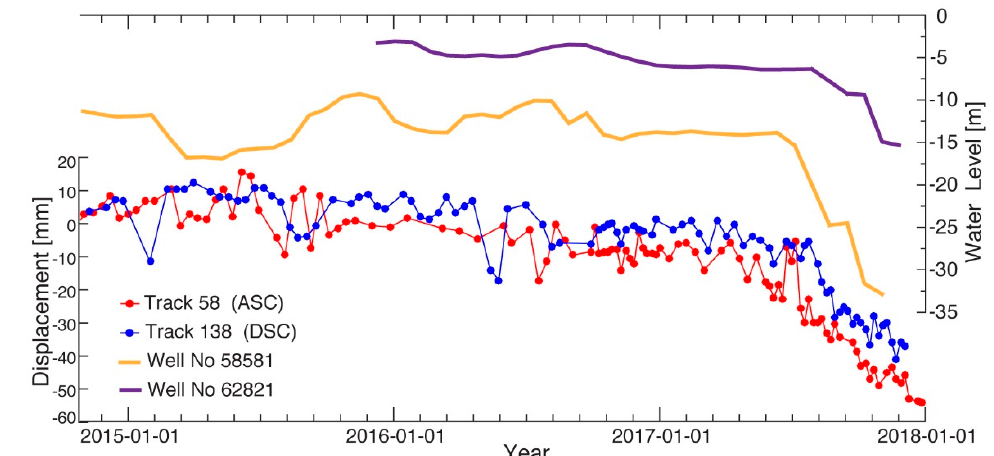
Figure 8. Temporal evolution of the subsidence of selected points within the black solid circle shown in Figure 4. Locations of well #58581 and #62821 are shown in Figure 2b. The blue line represents the displacement measured using T138 descending data, and the red line represents the displacement measured using the T58 ascending Sentinel 1 data. Orange and purple lines represent the water level at wells #58581 and #62821, respectively.